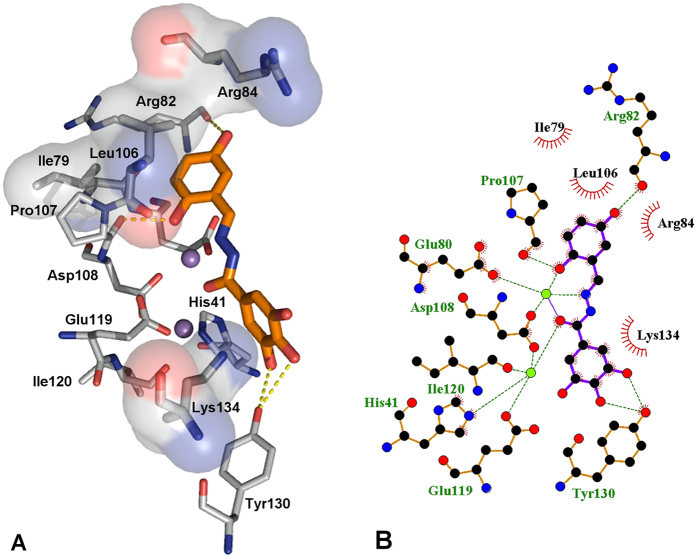
(A) Binding mode of compound 15 (orange) in complex with PA endonuclease. Key residues of the pocket are presented using PyMOL [ http://www.pymol.org] and LIGPLUS [Laskowski, R. A.; Swindells, M. B. Journal of chemical information and modeling
2011,
51, 2778]. Hydrogen bonds are illustrated by dotted lines while the divalent metal ions are shown as purple spheres. (B) Schematic drawing of the interactions of compound 15 generated using LIGPLUS. Dashed lines are hydrogen bonds and ‘eyelashes’ show residues involved in hydrophobic interactions.